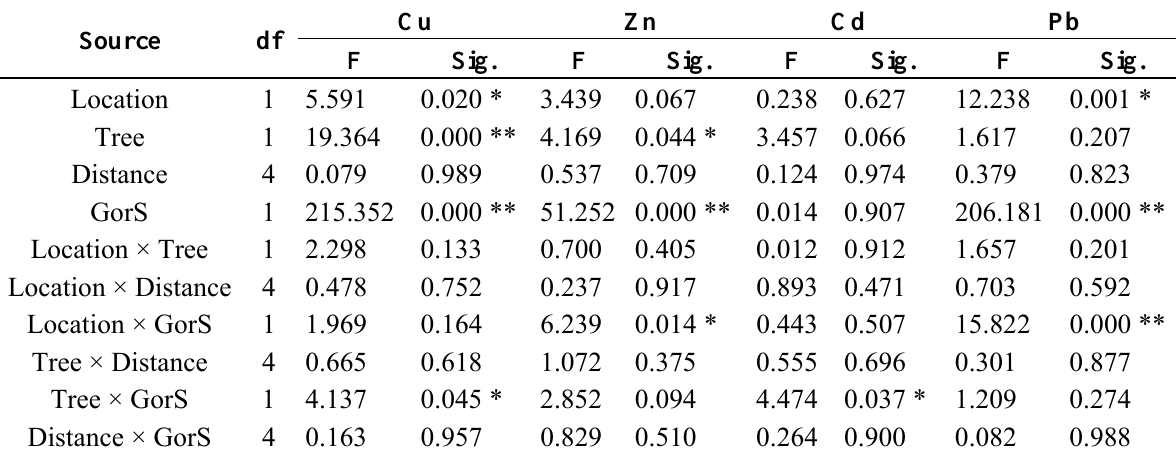
Table 7. MANOVA of heavy-metal